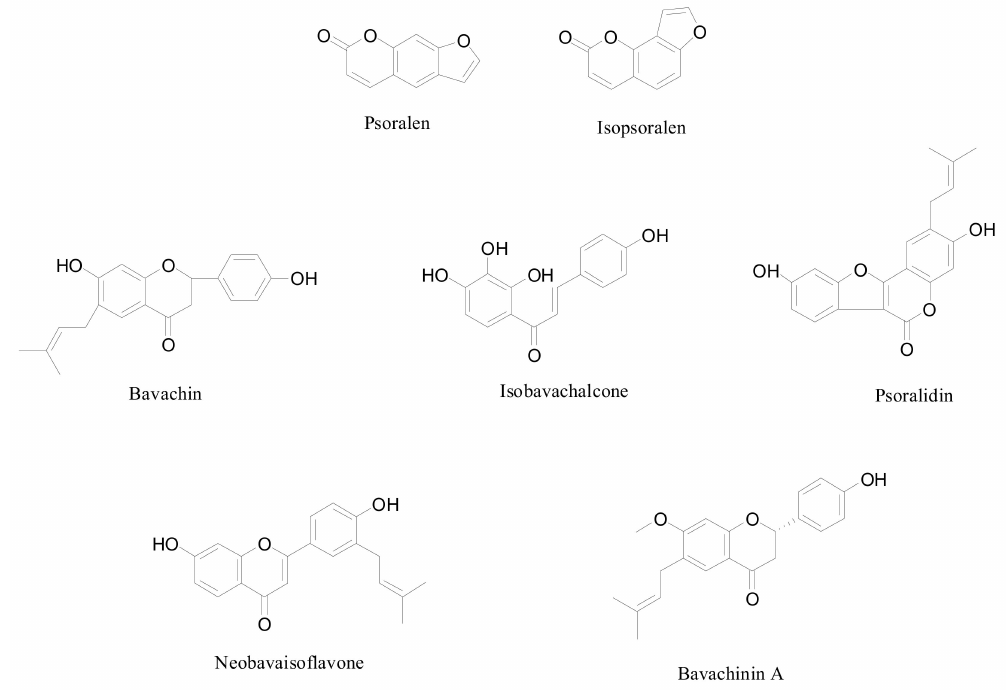
Figure 1. Chemical structures of seven compounds from Psoralea Fructus